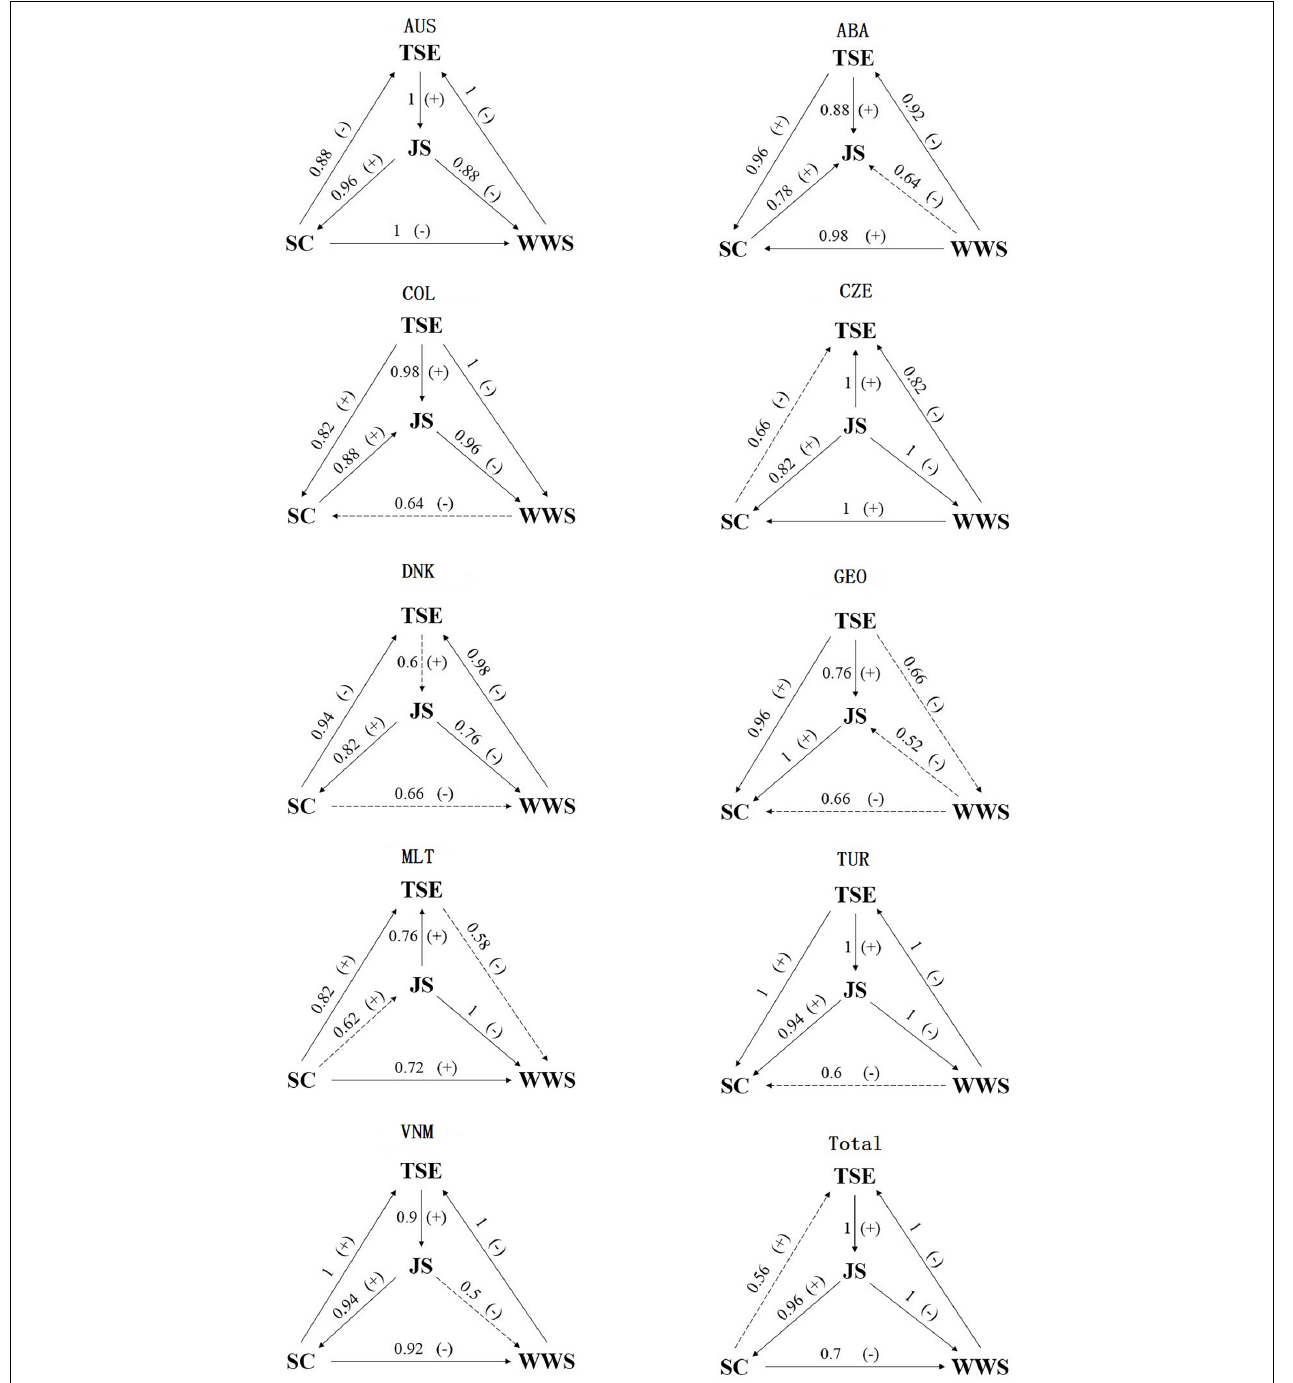
FIGURE 6 | Kernel causal paths of the nine countries/economics and total samples. P(cause) is marked on the line. “+” denotes positive correlated, and “–” denotes negative correlated. The solid line means kernel causality with acceptable probability, and the dotted line means unconvinced kernel causality.